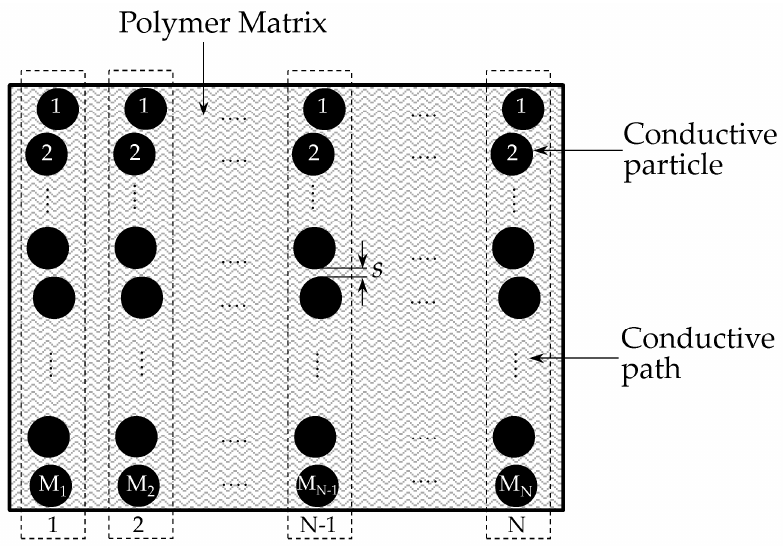
Figure 7. Schematic representing the particle distribution along the insulating polymer matrix. Theoretical description proposed by Wang et al. [23].